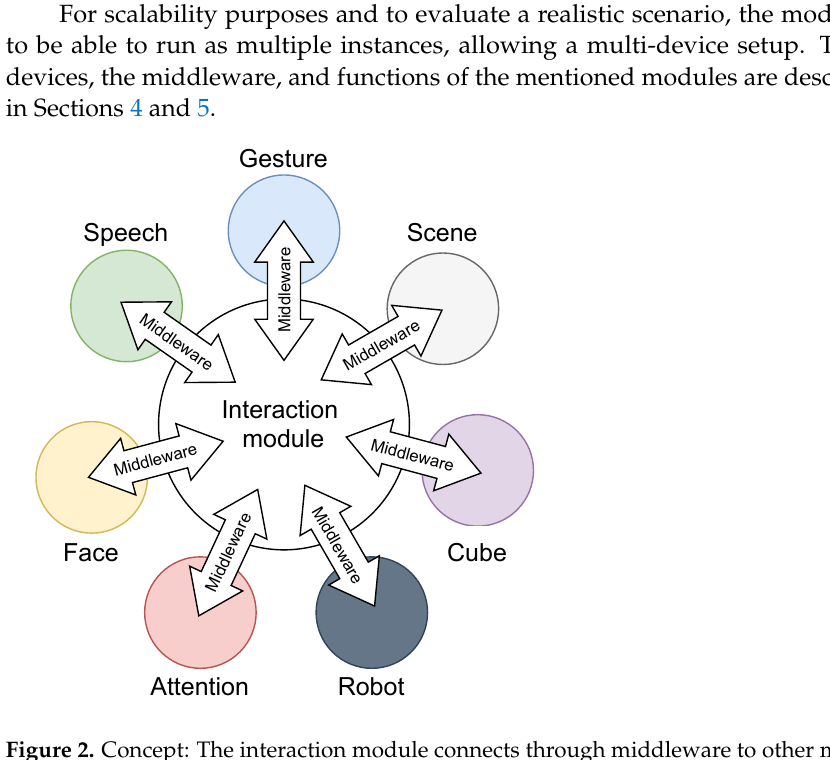
Figure 2. Concept: The interaction module connects through middleware to other